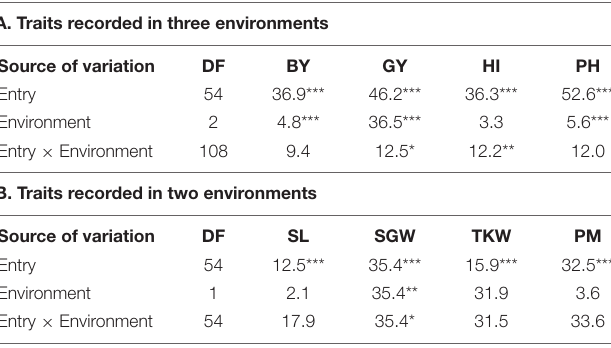
TABLE 3 | Genotypic and environmental effects and their interaction on the agronomic traits of barley lines selected under ultra-low density when evaluated under dense stand trials in different environments in Tunisia.